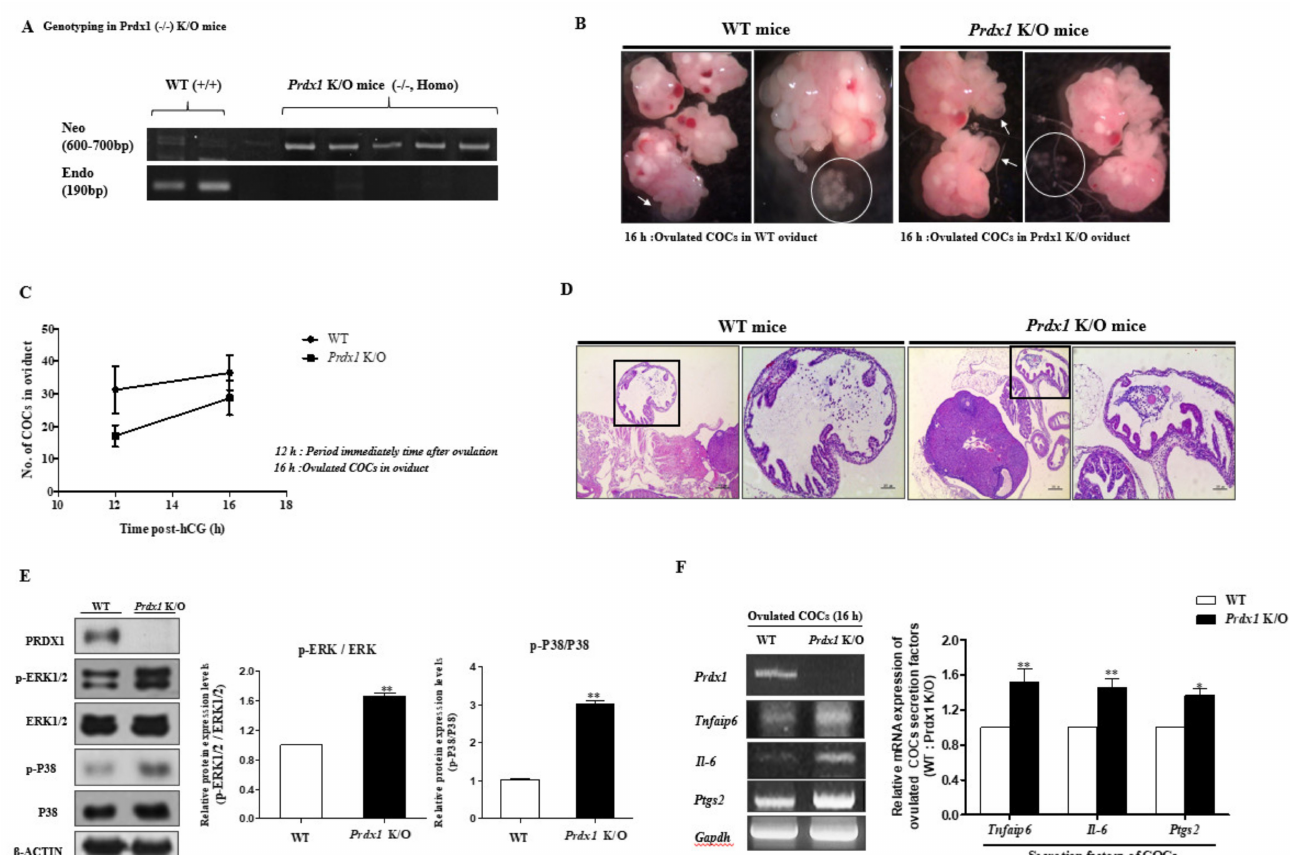
Figure 5. Effects of Prdx1 defection on the number of ovulated COCs, COC-secreted cytokines, and the ERK1/2 signaling pathway in Prdx1 K/O mice. ( A ) We performed genotyping of the Prdx1 gene by PCR in the tails of Prdx1 K/O mice and WT mice. ( B ) Microscope images showing the number of ovulated COCs taken directly from the oviduct in Prdx1 K/O mice compared with WT mice. ( C ) Quantification and graph of the reduced number of ovulated COCs in Prdx1 K/O mice. ( D ) Ovulated COC number and CC expansion in the oviduct of Prdx1 K/O mice were observed by hematoxylin and eosin (H&E) staining. ( E ) TLR4 signal-mediated ERK1/2 MAP kinase pathway in the ovulated COCs of Prdx1 K/O mice analyzed by Western blotting for the TLR4-derived MAP kinase signaling markers (p-P38, P38, p-ERK1/2, and ERK1/2) and PRDX1 protein expression in Prdx1 K/O mice. These protein levels were normalized to β -ACTIN expression as a control. The p-ERK was normalized to total ERK1/2 protein. ( F ) Changes in the mRNA levels of Prdx1 and COC secretion factors ( Tnfaip6, Il-6, and Ptgs2 ) were investigated in ovulated COCs of Prdx1 K/O mice by RT-PCR analysis. The levels of these genes were normalized to the Gapdh mRNA expression level as a control. Histogram values of the densitometry analysis were obtained using ImageJ software. Bar graph data represent the least-squares means ± SEM of three independent experiments. (*, p < 0.05, **, p < 0.01 compared with WT